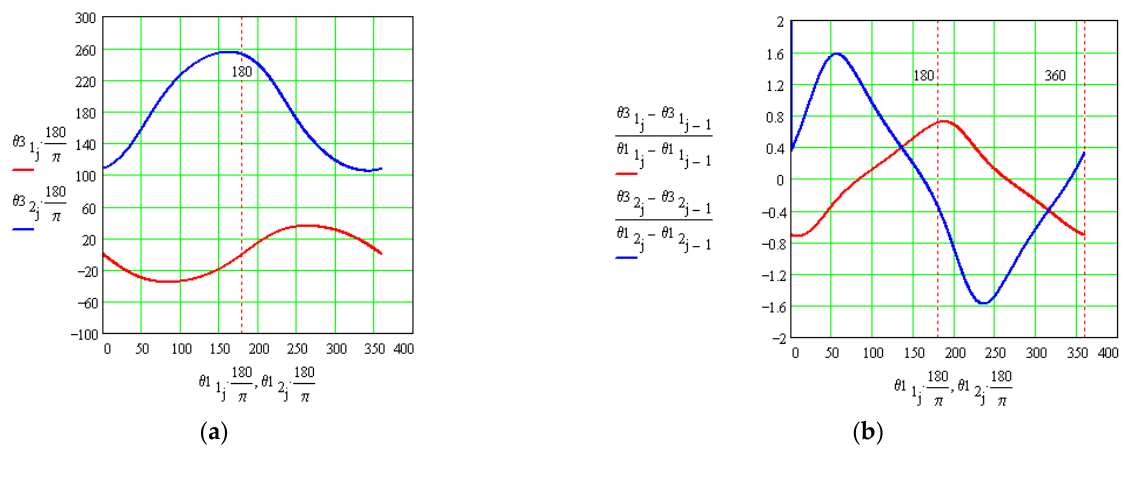
Figure 19. The angle of rotation ( a ) and the angular velocity ( b ) of the intermediate element with respect to the driven element.